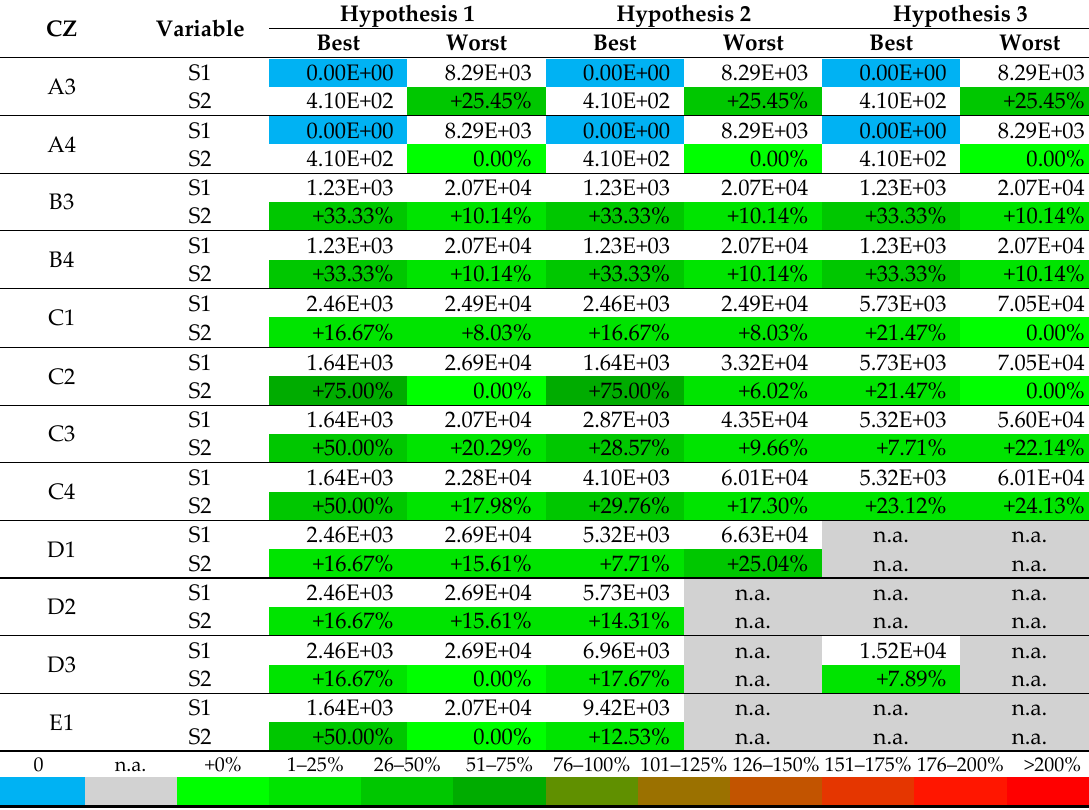
Table 9. Increase of emissions due to the constructive solution for the best and worst set ups.